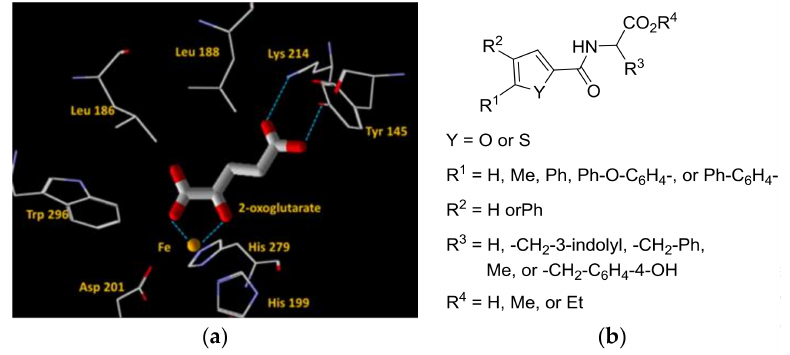
Figure 2. ( a ) The coordination of 2OG in the active center of FIH-1 (PBD ID: 1MZF); ( b ) The structure of the newly designed FIH-1 inhibitor structure based on the 2OG scaffold.